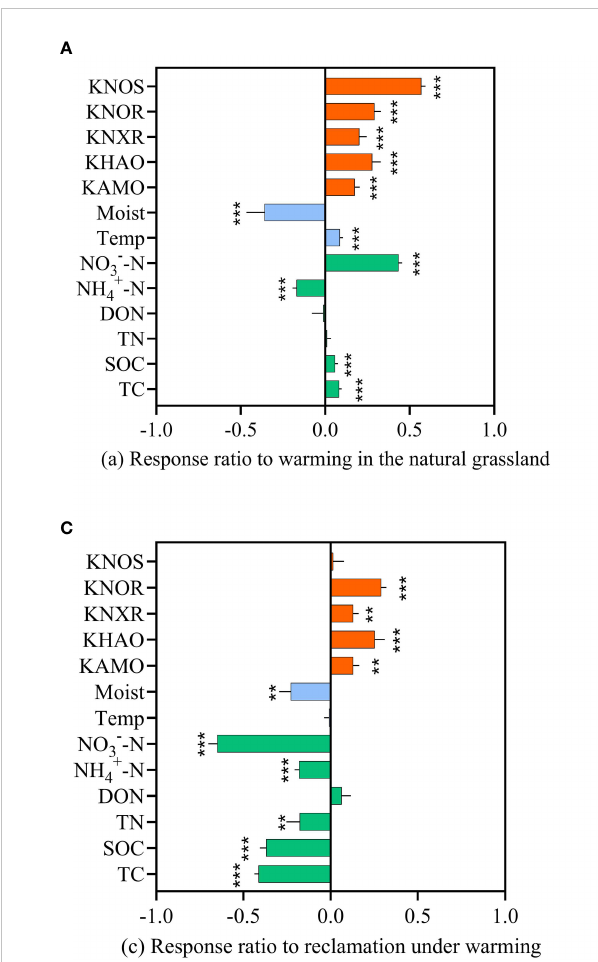
FIGURE 4 Response ratio (r) of soil properties and enzymatic activities under each treatment. (A) warming in natural grassland: shows the difference between CK and W, (B) reclamation without warming: shows the difference between CK and R, (C) reclamation under warming: shows the difference between W and WR. “ * ” indicates p < 0.05, “ ** ” indicates p < 0.01, and “ *** ” indicates p < 0.001. TC: soil total carbon, SOC: soil dissolved carbon concentration, TN: soil total nitrogen, DON: soil dissolved organic nitrogen, NH4+-N: soil ammonium concentration, NO3 – N: soil nitrate concentration, Temp: soil temperature, Moist: soil volumetric moisture, KAMO: enzymatic activity of AMO, KHAO: enzymatic activity of HAO, KNXR: enzymatic activity of NXR, KNOR: enzymatic activity of NOR, KNOS: enzymatic activity of